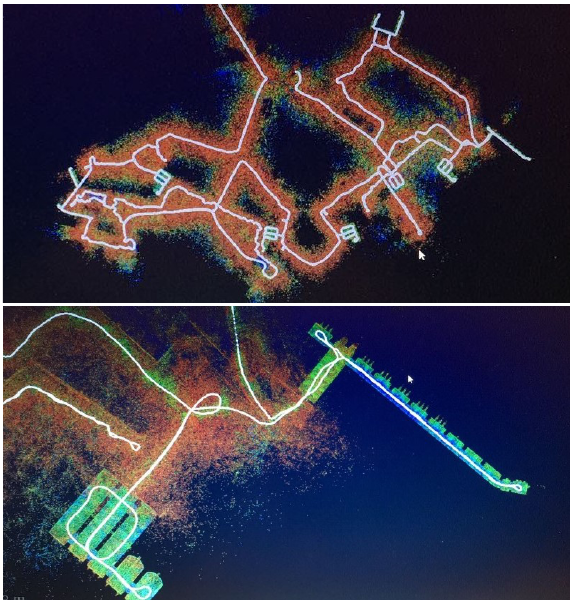
Figure 4. Views of the Pegasus Backpack registered point cloud and of the adjusted trajectory followed during the acquisition.